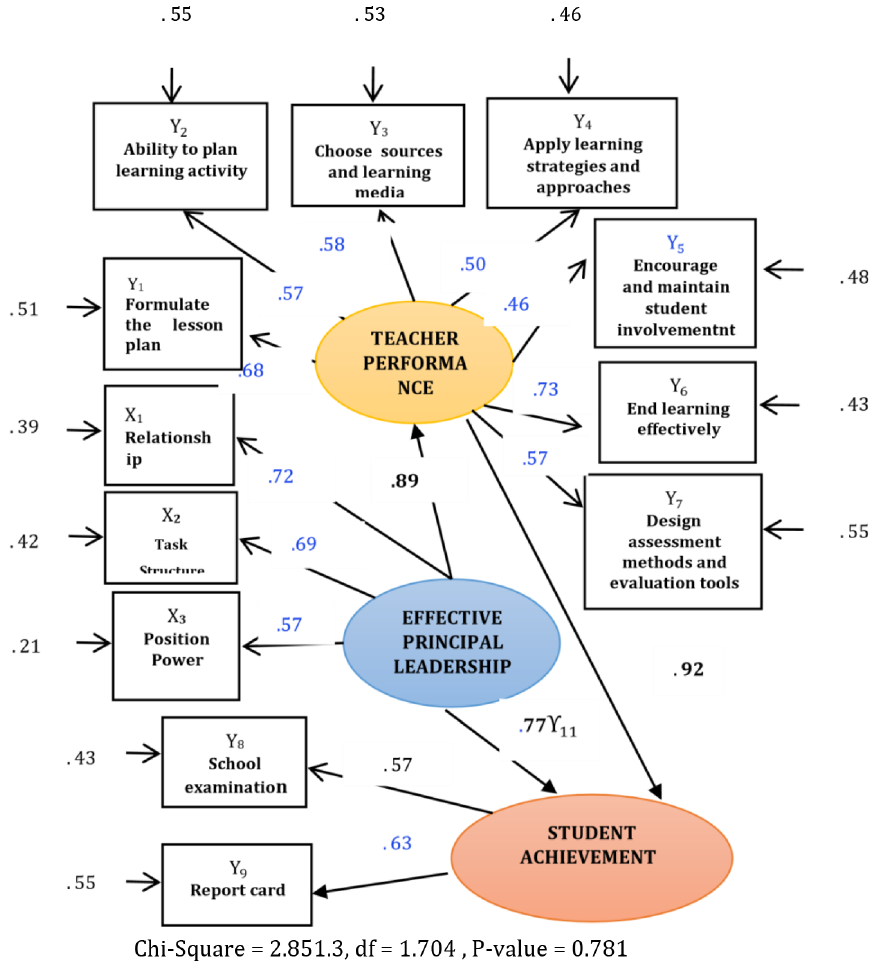
Figure2.Theinfluencemodelofeffectiveprincipalleadershipbehaviorsonteacherperformance andstudent achievement. Note: Value of Standardized loading factor 0.30 Carmines and Zeller in Sugiyono